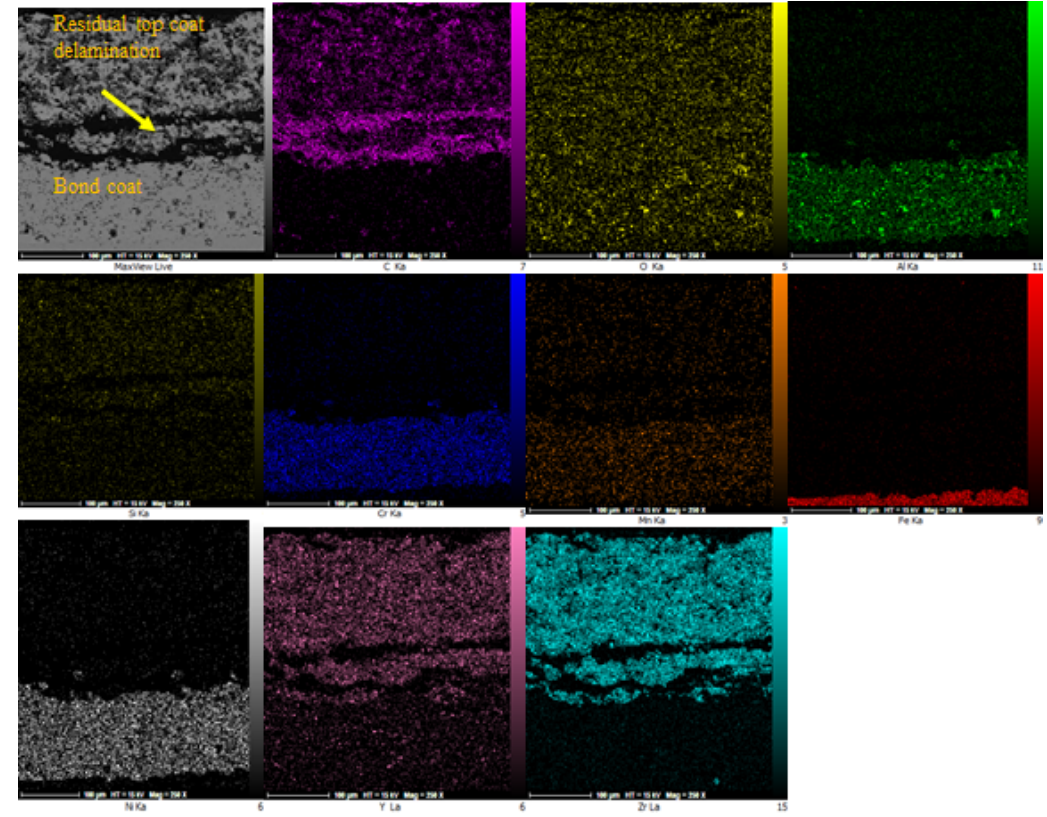
Figure 23: Map patterns of exhaust valve thicker coating 1000 µ m